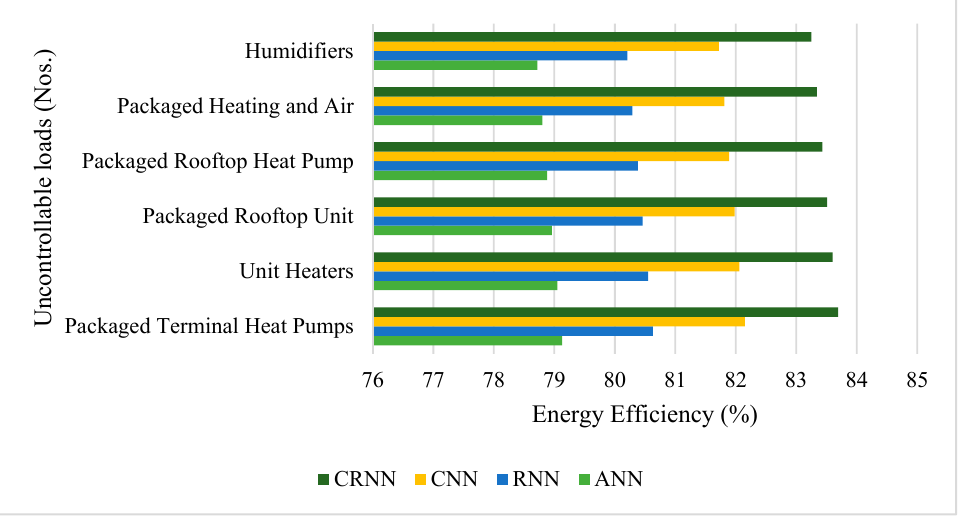
Figure 11. Energy efficiency (%) over various deep learning algorithms with uncontrollable loads.